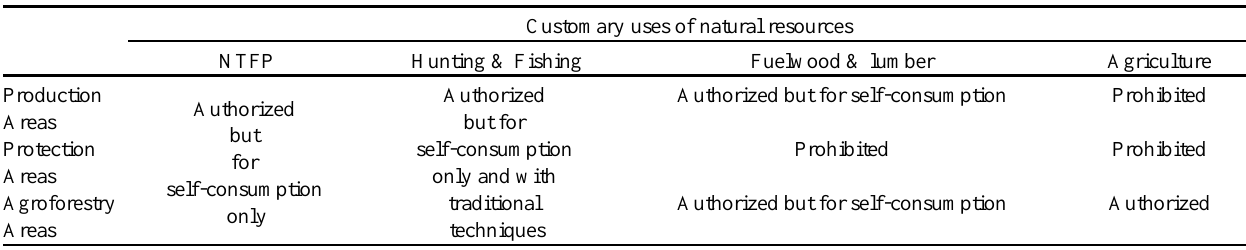
Table 1 . Legal constraints to local uses in a logging concession.